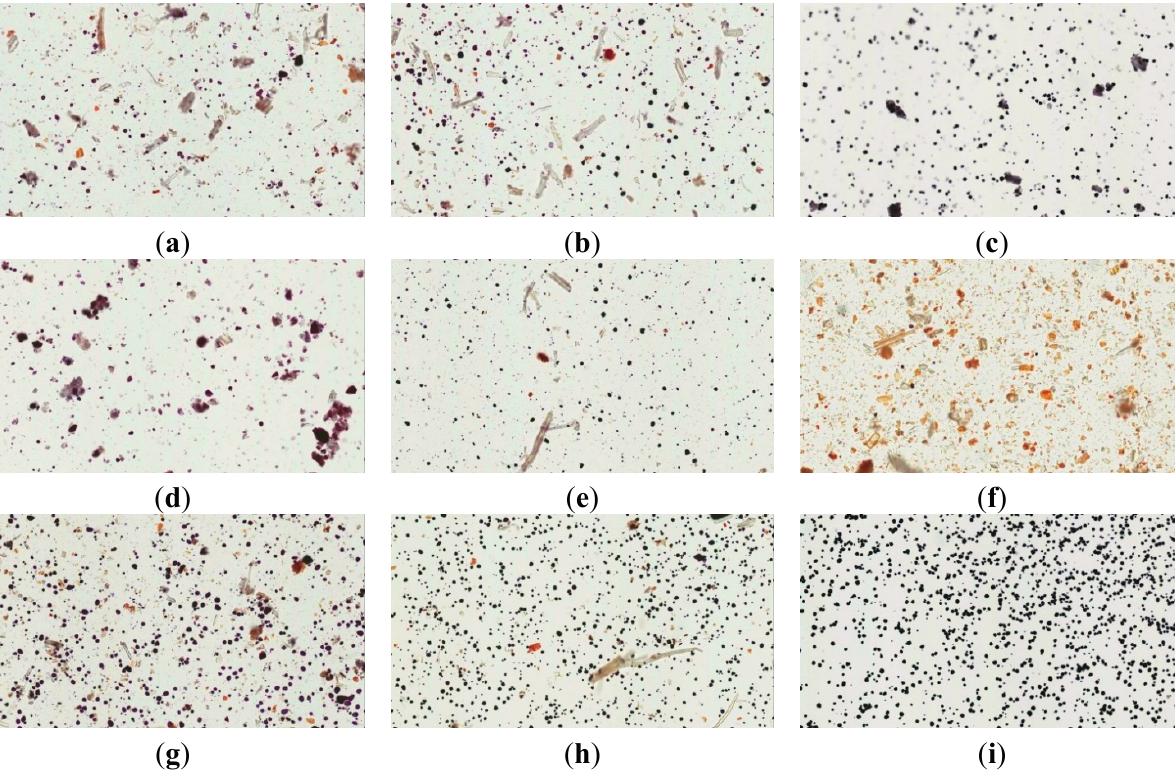
Figure 4. Light microscopy images of iodine-KI stained samples: ( a ) brand A; ( b ) brand B; ( c ) brand C; ( d ) brand D; ( e ) brand E; ( f ) herbal powder; ( g ) herbal powder:brand A = 1:1; ( h ) corn starch:herbal powder = 1:1 and ( i ) corn starch.